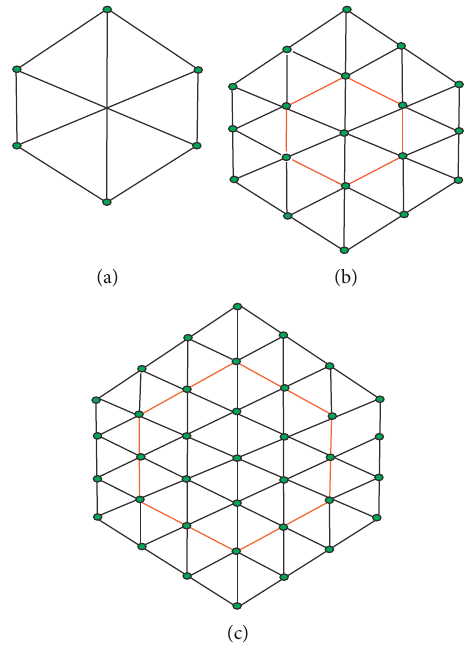
Figure 1: Hexagonal networks: (a) HX(2), (b) HX(3), and (c) HX(4).